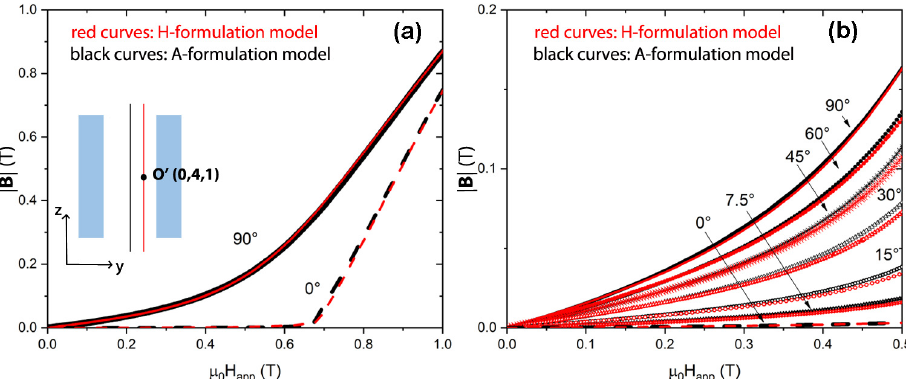
Figure 3. Comparison between the magnetic flux density values calculated at point O’ (whose coordinates related to point O are (0 mm, 4 mm, 1 mm), i.e., 4 mm away from the tube center along the radial direction and 1 mm away along the axial one), using the H -formulation (red curves) and the A -formulation (black curves). Calculations were carried out in the axial and transverse field orientations ( a ) and for different angles of the applied field ( b